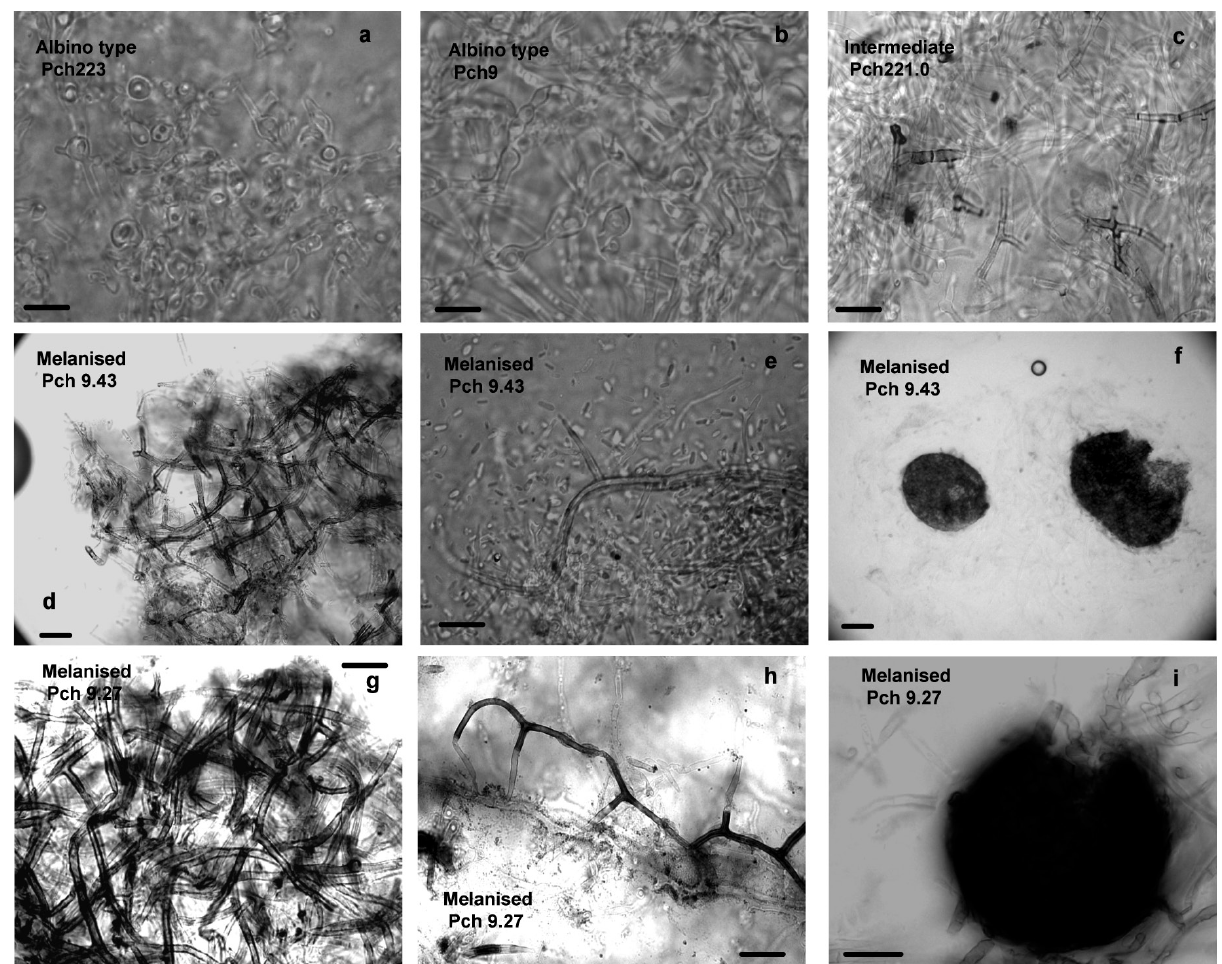
Figure 2. Micromorphological features of the several P. chlamydospora morphotypes recognized in the present study. a, Albino type (Pch 223) yeast-like somatic hyphae; b, albino type (Pch 9) yeast-like somatic hyphae; c, intermediate type (Pch 221.0) filamentous hyphae; d, e, f, melanised type (Pch 9.43) filamentous somatic hyphae, conidia production and Phoma -like synanamorph respectively; g, h, i, melanised type (Pch 9.27) filamentous somatic hyphae, conidiomata and Phoma -like synanamorph respectively. Bars = 10 μ